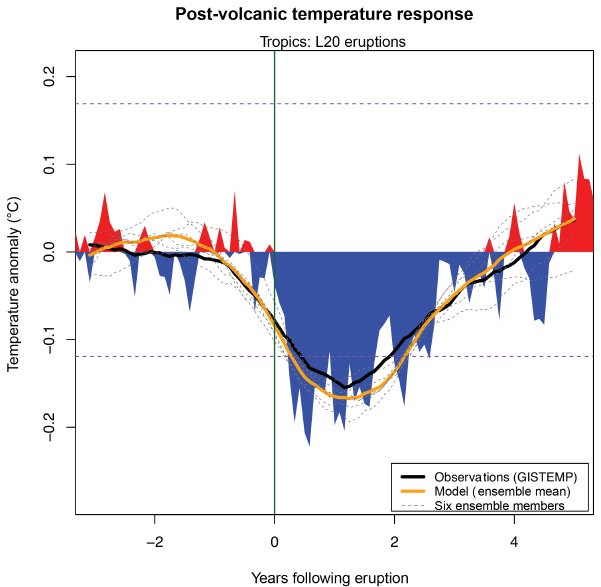
Figure 4. Composite tropical (30 ◦ S to 30 ◦ N) temperature re- sponse following the L20 volcanic eruptions. Fill colors denote ob- served monthly anomalies using GISTEMP, with 24-month running average shown as a solid black line. ModelE2-R ensemble mean is shown as solid orange line and dashed grey lines indicate the six individual ensemble members. Anomalies are referenced to 5 years prior to eruptions (years − 5 to 0). Dashed purple lines encompass the 5–95% interval for monthly tropical-mean temperature anoma- lies (relative to the previous 5-year mean) in the GISTEMP prod- uct from 1950 to present. The calculation of this range omits data 2 years after the L20 eruptions. The range is not symmetric about zero due to the tropical warming trend during this interval. All data are based on the ENSO-removal technique discussed in the